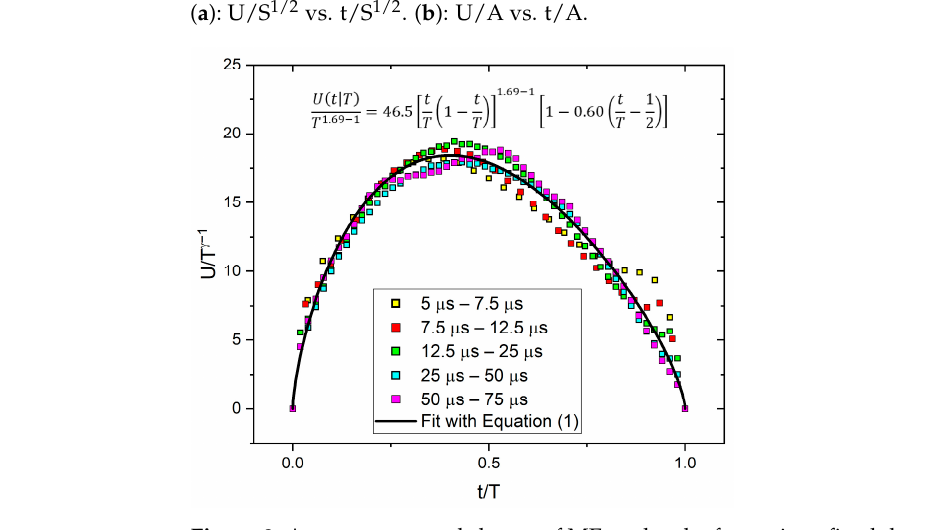
Figure 7. Average temporal shapes of ME avalanches for various fixed avalanche size ranges. ( a ):